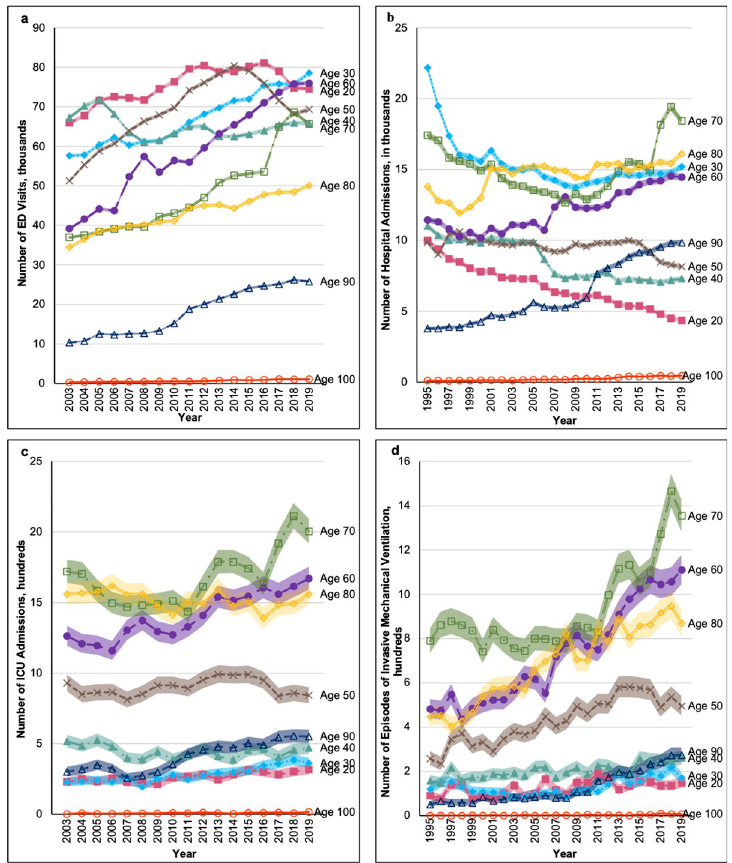
Fig 4. Secular trends in age stratified volumes of: a) emergency department visits; b) hospital admissions c) intensive care unit admissions; and d) receipt of invasive mechanical